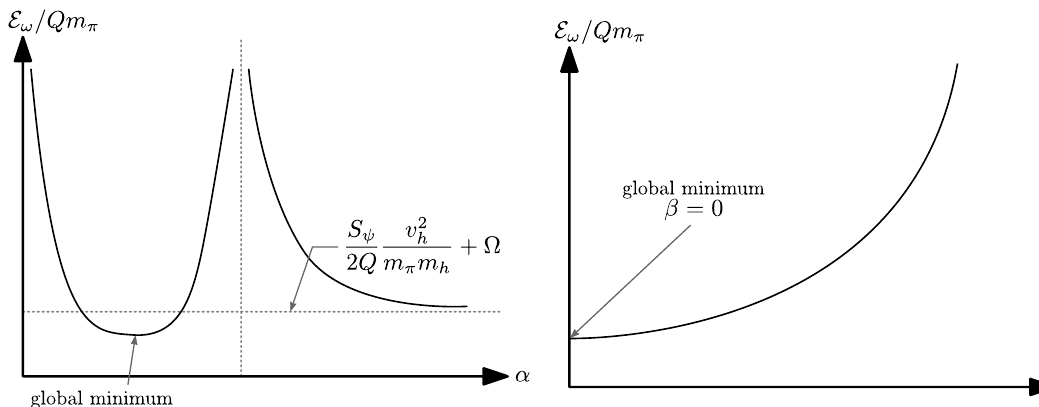
Figure 2 . The schematic behaviour of the dimensionless energy functional E ! =Qm (cid:25) in eq. (3.11) as a function of (cid:11) and (cid:12) , for typical choices of parameters. It can be seen that the formation of a Higgs VEV inside the Q-ball is energetically favoured, whilst the formation of a neutral pion VEV is